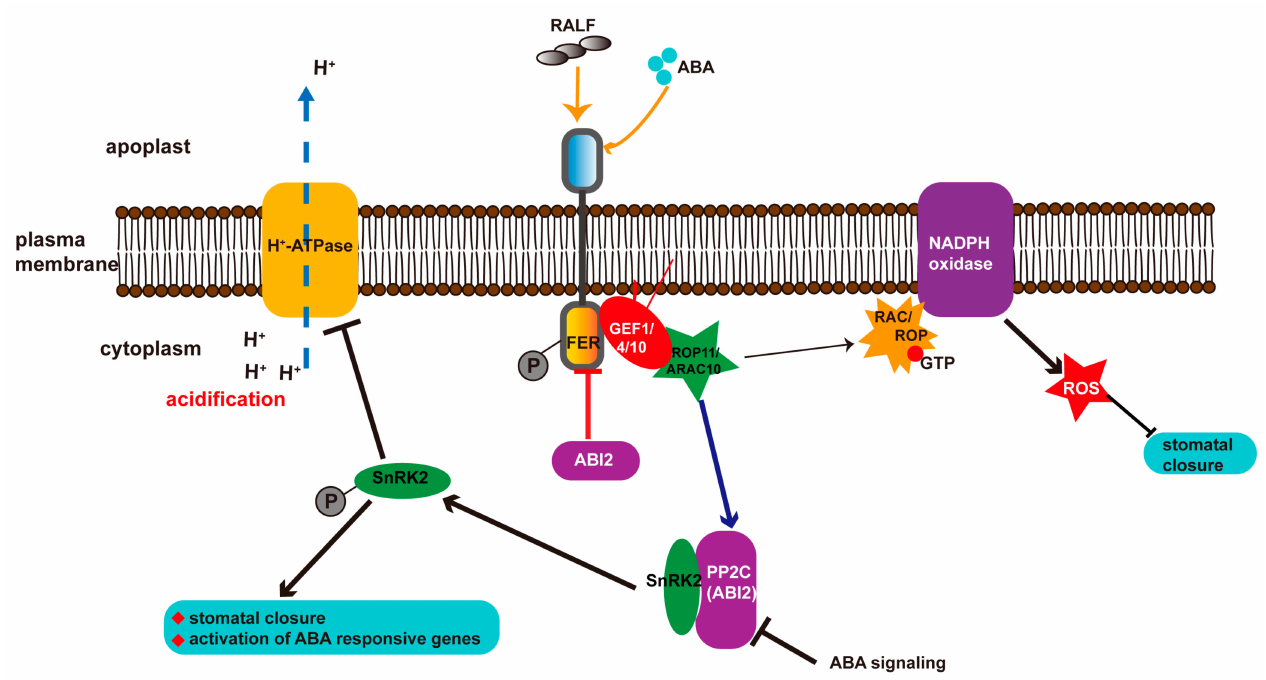
Figure 2. Schematic representation of the role of FER in the ABA signaling pathway. ABA directly represses ABI2 activity and releases activated SnRK2. Upon activation, SnRK2 induces expression of ABA-responsive genes and stomatal closure, inhibits H + -ATPase activity, and induces acidification of the cytosol, leading to inhibited cell growth. RALF and ABA increase the phosphorylation levels of FER, while FER activates ABI2 activity through the GEF1/4/10–ROP11/ARAC10 pathway, thereby inhibiting the ABA response [43]. FER also regulates ROS production through the GEF1/4/10- ROP11/ARAC10 pathway to regulate ABA-mediated stomatal closure [43]. ABI2 interacts with and dephosphorylates FER to suppress the FER–GEF–ROP pathway